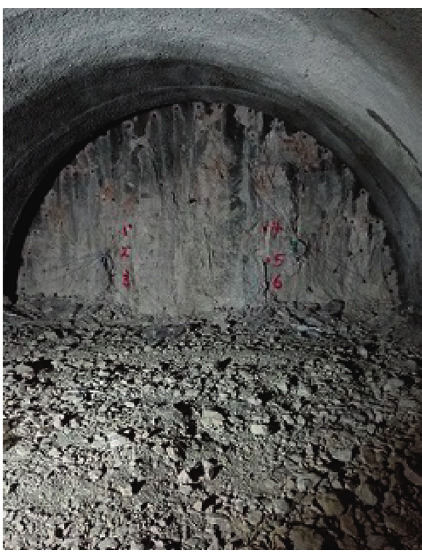
Figure 26: Layout of site blast holes. Figure